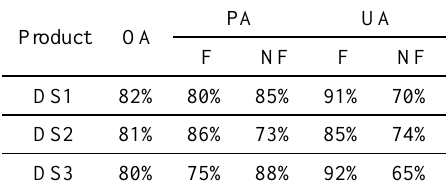
Table 2. Summary of accuracy numbers of the